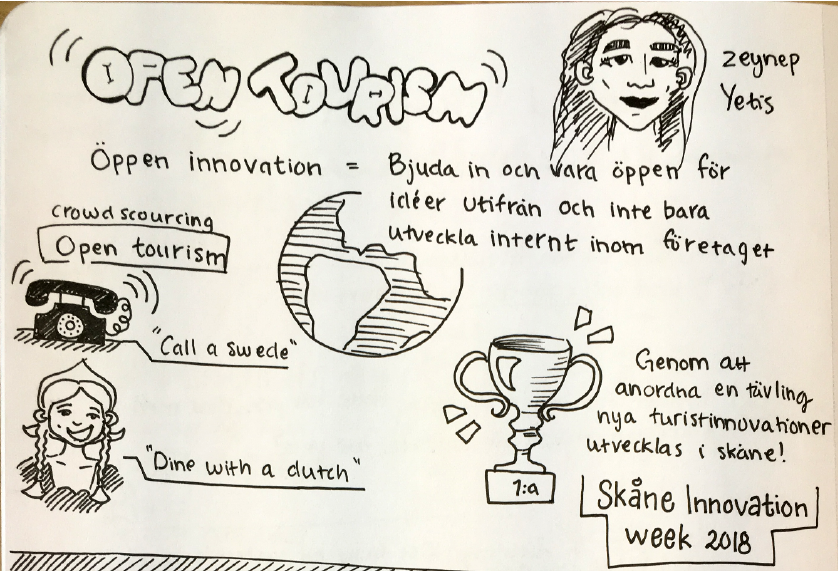
Figure 3. Open tourism (graphic recorder Johanna Balogh).